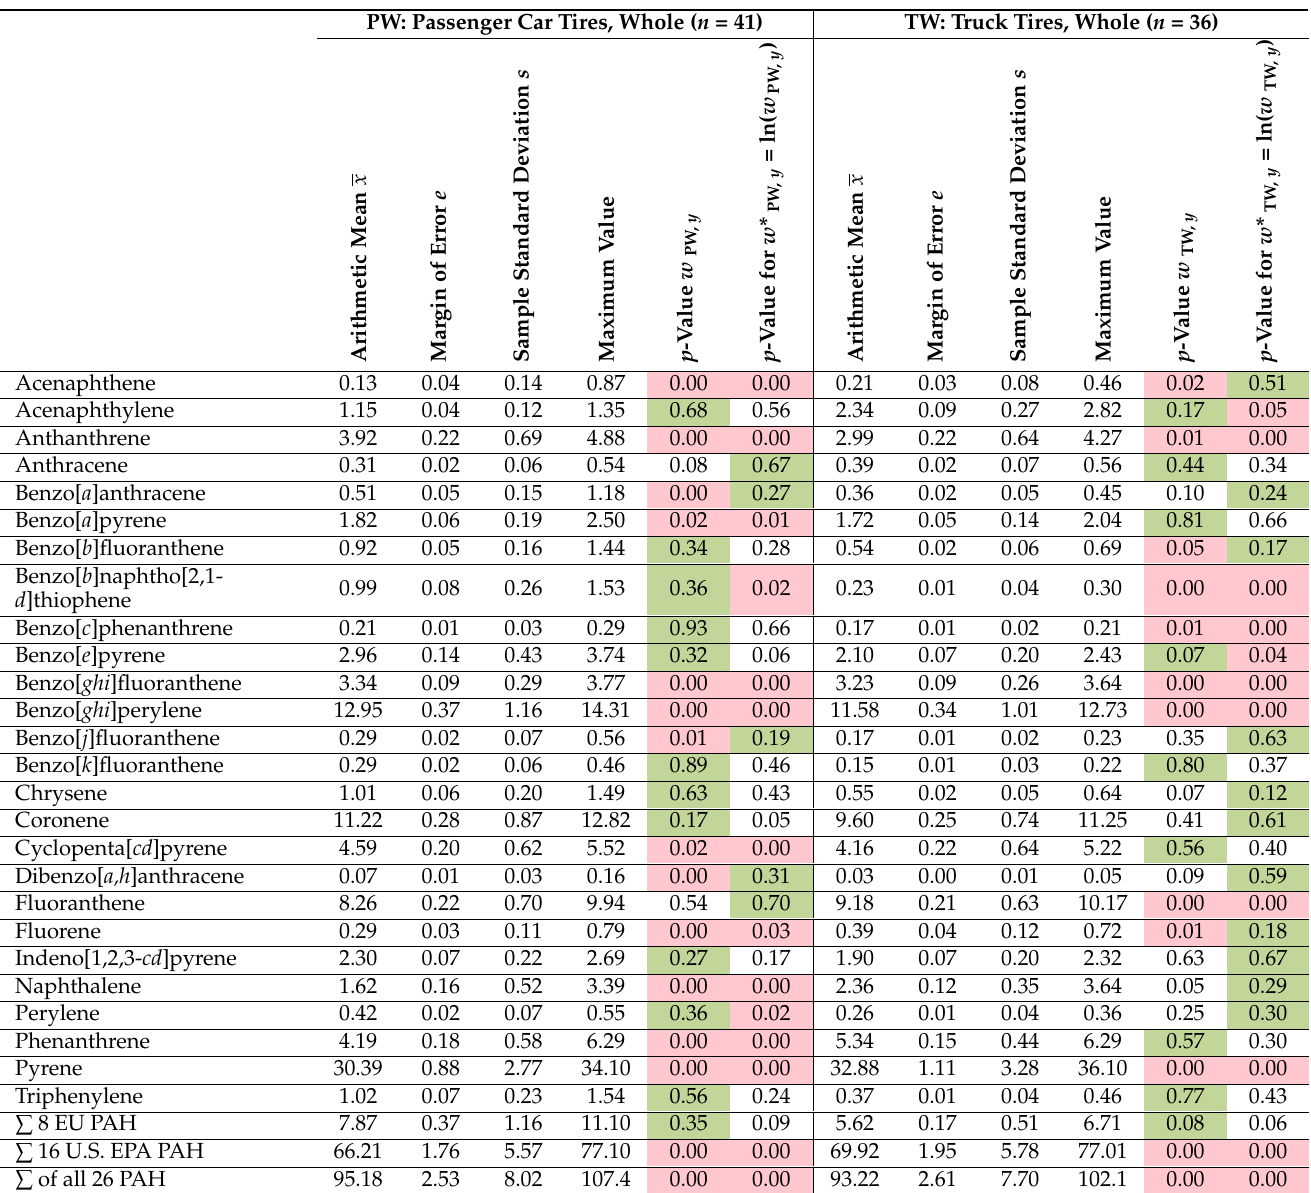
Table 3. Statistical indicators for whole passenger car tires (PW) and whole truck tires (TW). PW: Passenger Car Tires, Whole ( n = 41) TW: Truck Tires, Whole ( n =